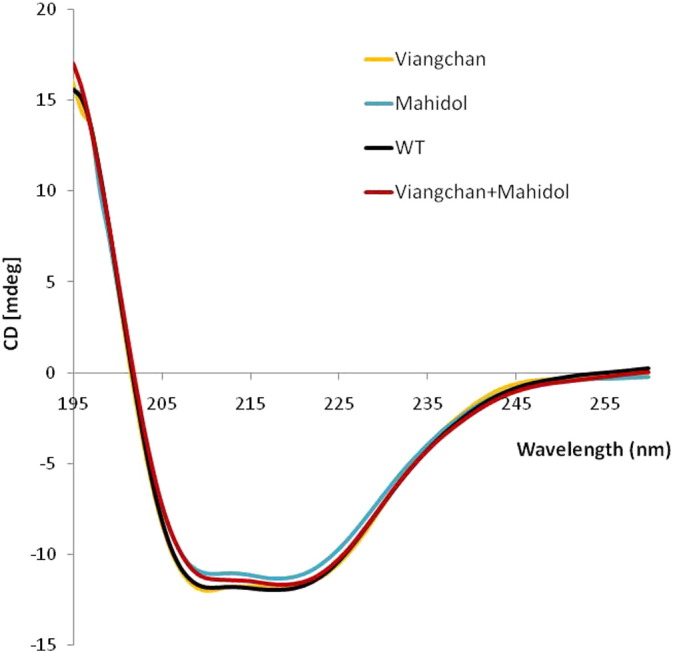
Circular dichroism (CD) spectra of recombinant human G6PD enzymes: WT, G6PDMahidol, G6PDViangchan and G6PDViangchan + Mahidol. The protein concentration was 0.35 mg/ml in 20 mM Tris-HCl pH 7.5.